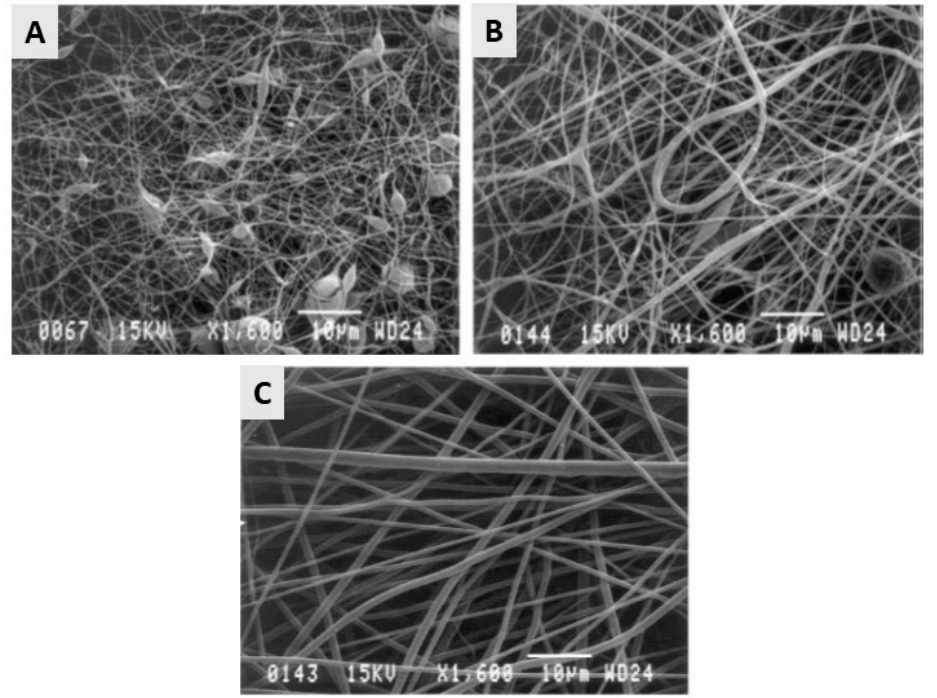
Figure 12. Scanning electron micrographs of control-group electrospun PGA at 1600× magnification. ( A ): 67 mg/mL with 0.22 ± 0.07-µm fibers (excluding beads) and 1.84 ± 1.08-µm 2 pores. ( B ): 100 mg/mL with 0.42 ± 0.17-µm fibers and 3.53 ± 2.78-µm 2 pores. ( C ): 143 mg/mL with 0.88 ± 0.37-µm fibers and 13.22 ± 7.45-µm 2 pores—reproduced with permission from [155]. Copyright Wiley, 2004.